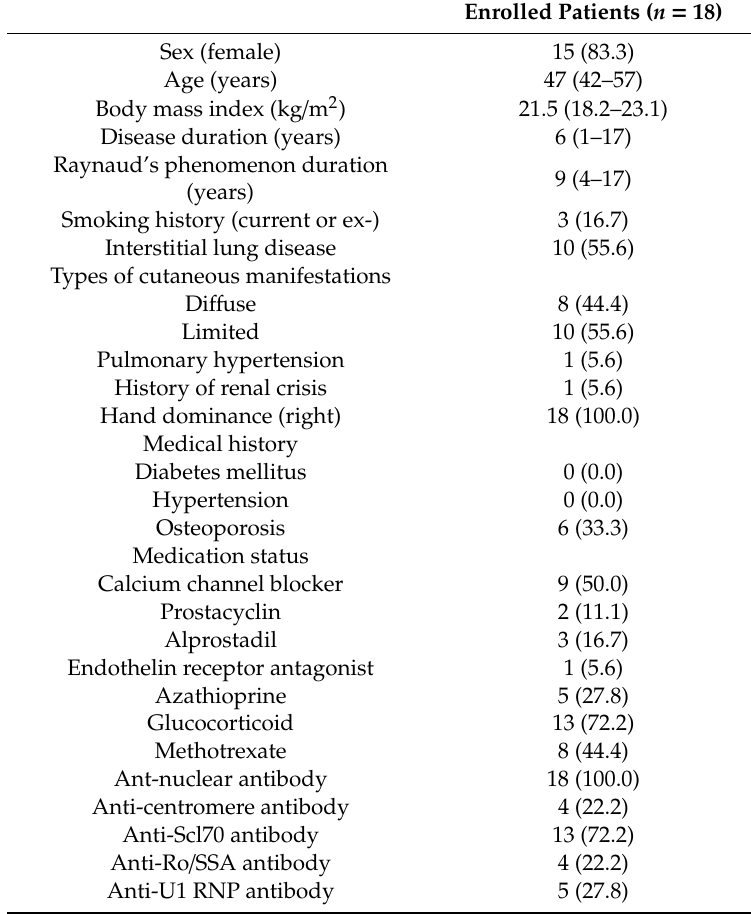
Table 1. Baseline characteristics of the enrolled